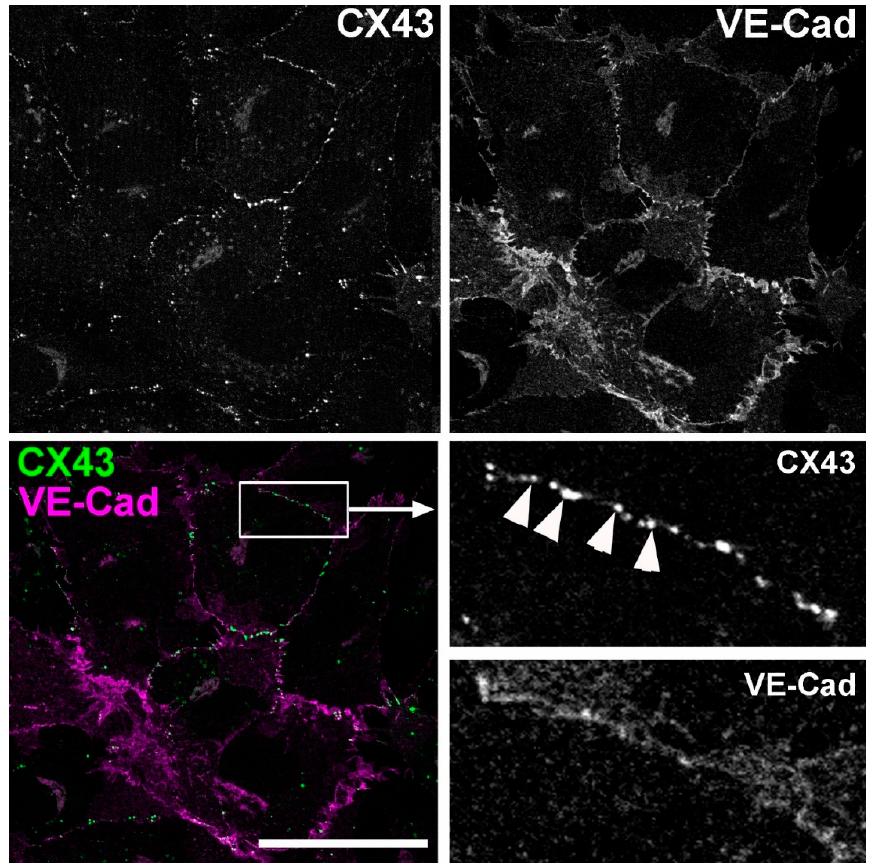
Figure 6. Cx43 positive localisation at cell–cell contact in cultured HUVEC. Confocal fluorescence images of HUVEC immune-labelled for endogenous Cx43 (1:25 dilution, top left and green in colour merged image) and VE-Cadherin (1:400 dilution, top right and magenta in colour merge image). Region indicated by white box in colour merge image is shown in grey scale on an expanded scale to right (pointed to by the arrow). Arrow heads indicate Cx43 puncta at cell–cell contacts. Images were acquired using a BioRad Radiance 2100 confocal microscope equipped with a 60 × 1.40 NA oil immersion objective and are representative of 6 independent experiments. Scale bar is 500 μ m.